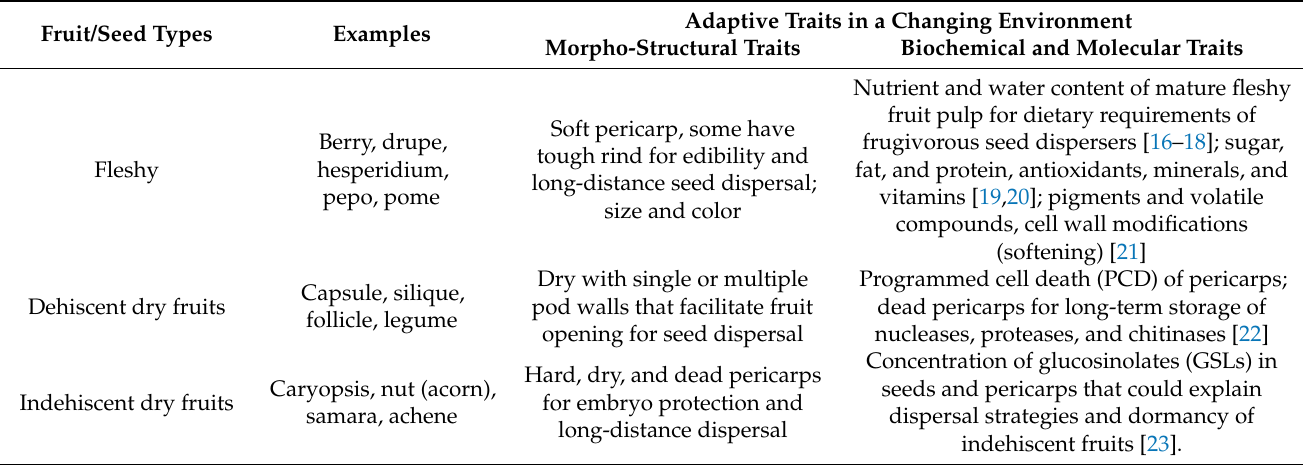
Table 2. Seed dispersal-related traits of fruit/seeds of different plants in a changing